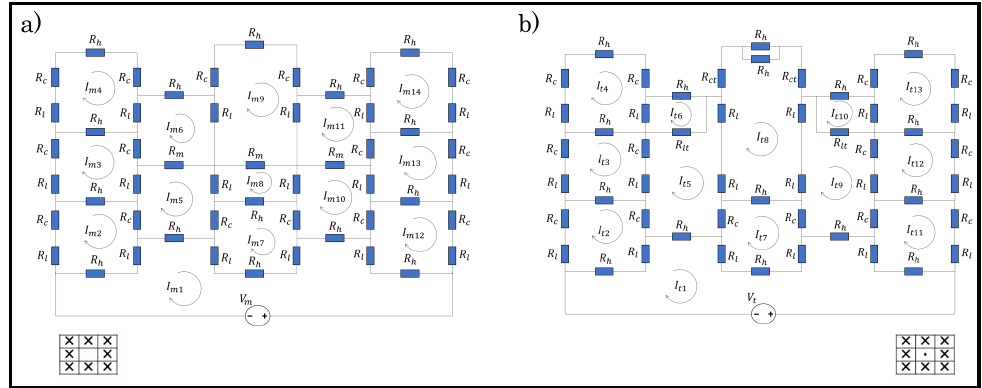
Figure 4. Resistive circuits of ( a ) a Miss stitch, and ( b ) a tuck stitch in a Weft Knit